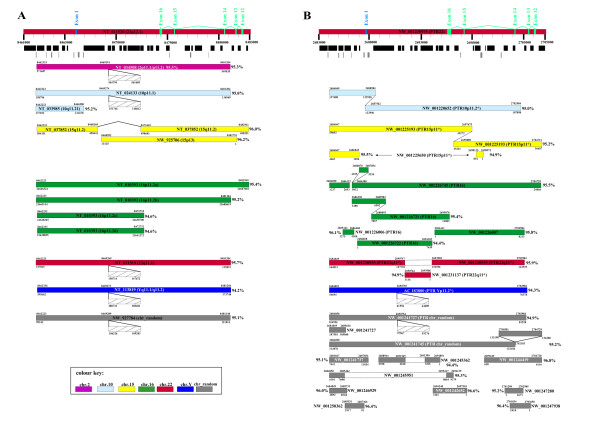
Comparative in silico analysis of CHEK2 duplicons in human and chimpanzee. Genomic structure of the CHEK2 duplicon family in the (A) human (NCBI Build36.2) and (B) chimpanzee (NCBI Build2) sequence assembly. The respective ancestral CHEK2 locus is depicted by the top horizontal red bar. Within each bar the corresponding accession numbers of the contigs and the position of the CHEK2 exons (green rectangles) and TTC28 exon (blue rectangle) are given. The precise genomic extension of the ancestral loci within each contig is shown beneath. The next two layers illustrate the common repeat and simple repeat content of the ancestral loci as black and grey boxes, respectively. All derivative duplicons are shown below using the indicated colour key. Precise positions of each derivative duplicon within the corresponding contig and the genomic extension of the sequence homology shared with the ancestral locus are indicated below and above each bar, respectively. Striped boxes represent LINE1 elements. LINE1 element integration-sites within the respective contigs are given below and the position of homology break within the ancestral locus is given above. Overall sequence identities between the paralogous human and chimpanzee CHEK2 duplicons and the respective ancestral CHEK2 sequences are given next to all CHEK2 duplicons.